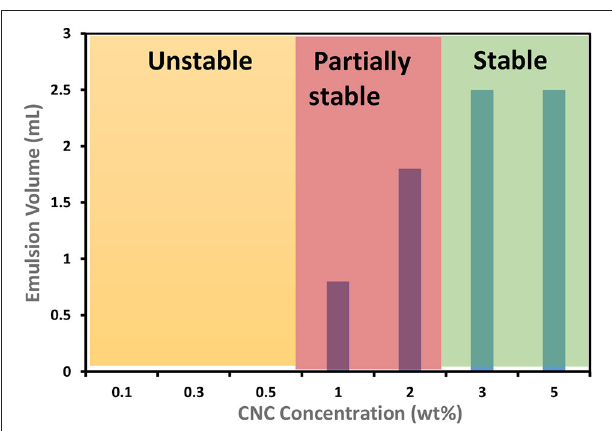
FIGURE 2 | Effect of CNC concentration on stability of emulsions prepared with canola oil and hexadecane (oil to water ratio is 2:8mL) at room temperature, pH =